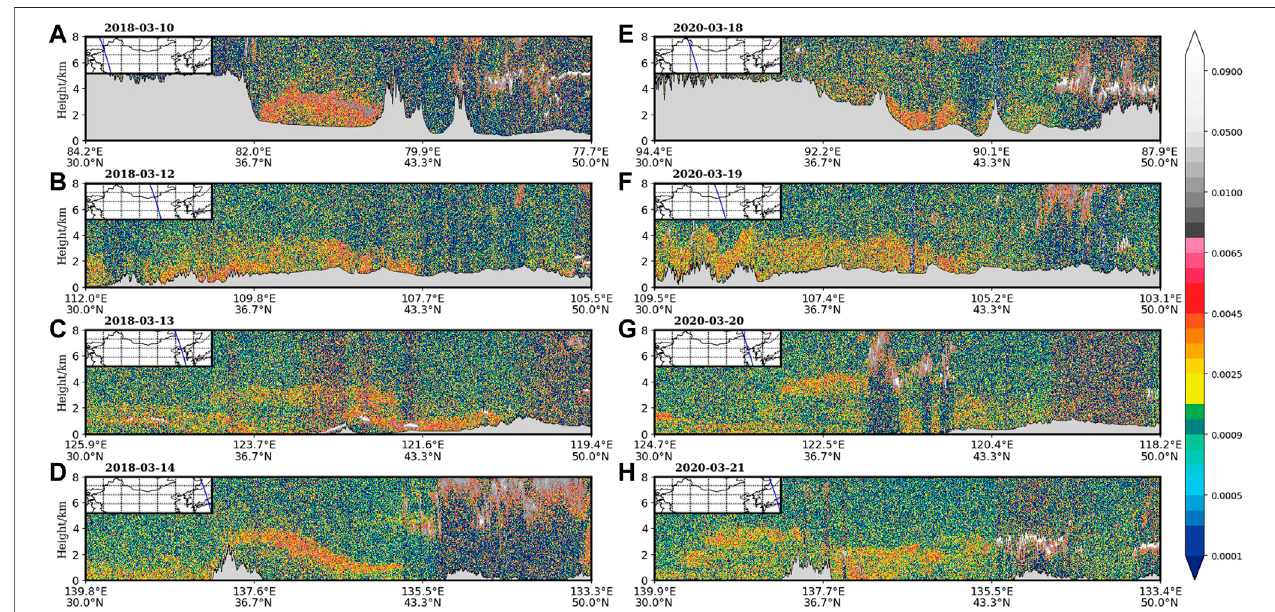
FIGURE 3 | Vertical distributions of the 532 nm total attenuation backscatter coef fi cient from CALIOP on March 10th, 12th to 14th in 2018 (A – D) , March 18th to 21st in 2020 (E – H) . (Black line shows the surface elevation).